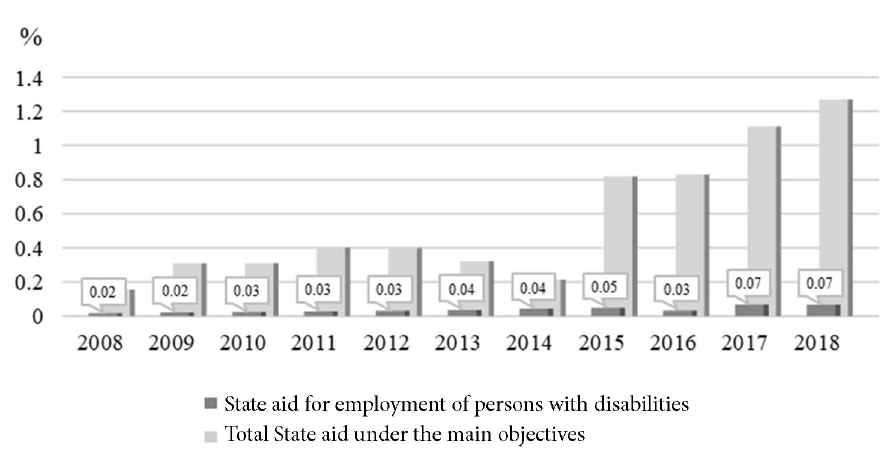
Figure 2. Comparison of State aid with GDP dynamics in Lithuania (per cent) (source: created by authors, based on data from the European Commision,